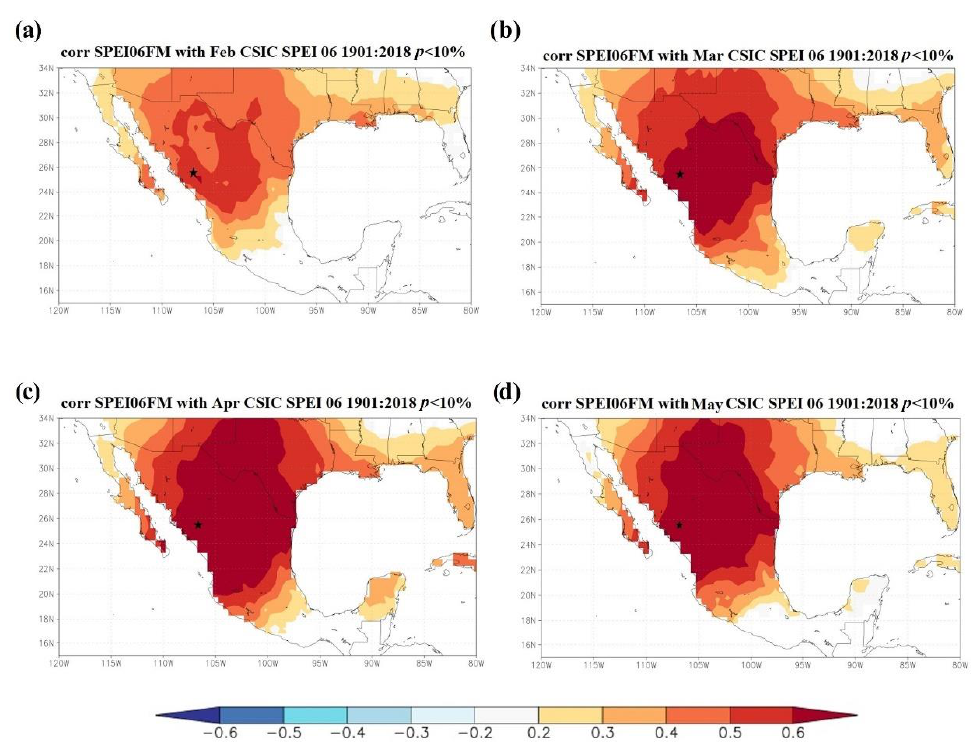
Figure 8. Spatial correlation between the reconstructed SPEI6 FM and the six-month cumulative SPEI of the Global Drought Monitor for the months used in the reconstruction: ( a ) February, ( b ) March, ( c ) April, and ( d ) May.